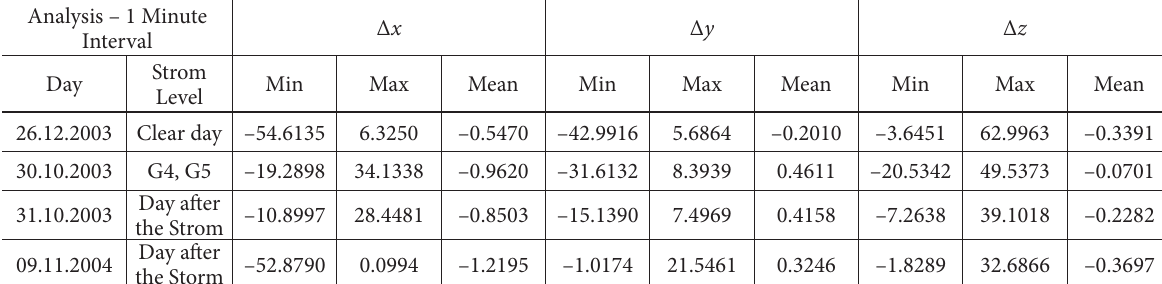
Table 6. Overview of days analyzed at 1 minute